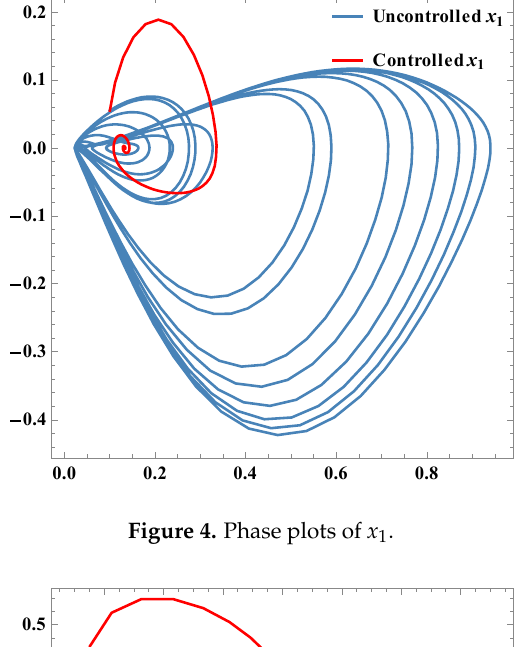
Mathematics 2016 , 4 , 33